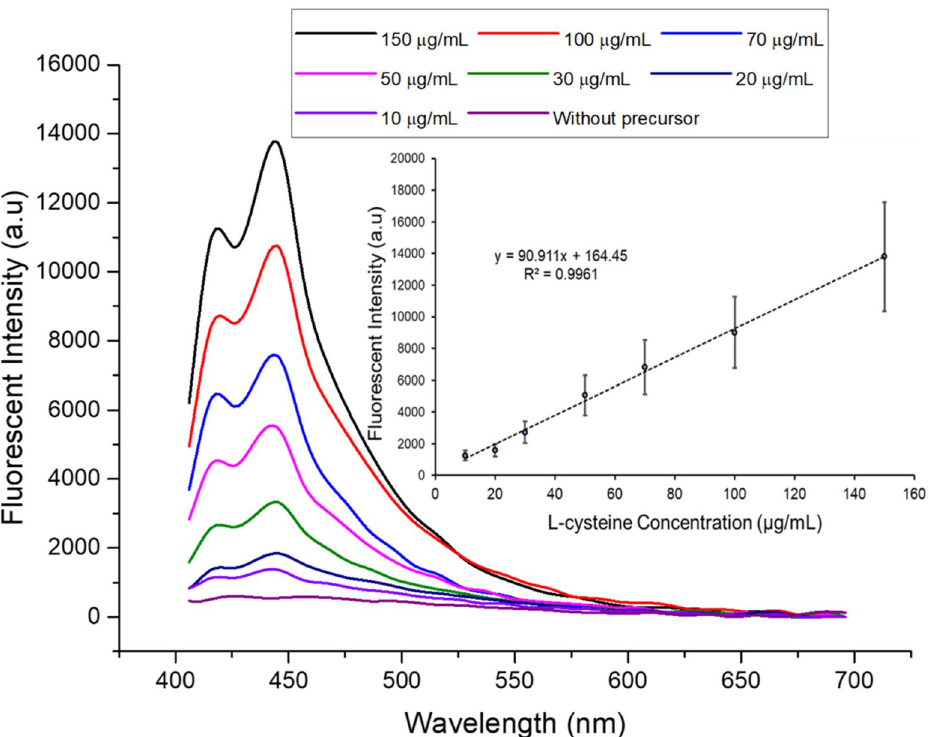
Figure 4. Fluorescence emission spectra of different concentrations of analyte (l-cysteine) within the sample analyzed by presented optimized procedure. Inset: linear response of calibration plot (Dopamine/l-cysteine